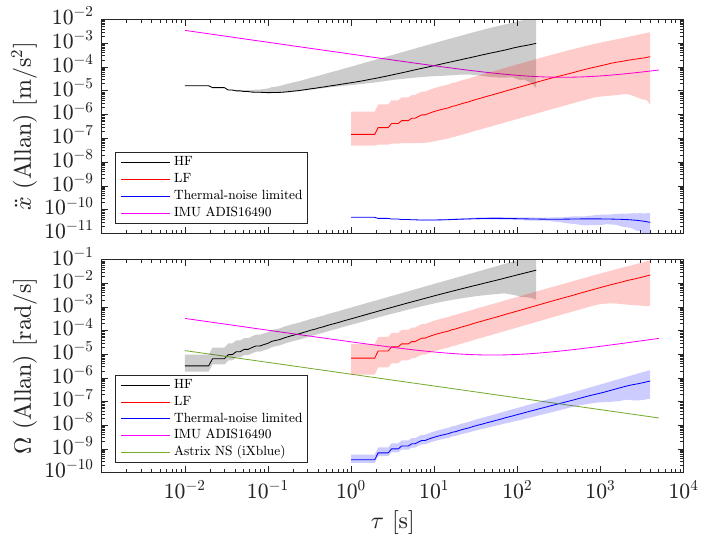
Figure 11. Allan deviation for linear acceleration ( top ) and angular velocity ( bottom ). HF and LF GF-INSs performance are shown in black and red, respectively. A tactical-grade MEMS-based inertial sensor (ADIS16490 from Analog Devices) and an optical gyroscope (Astrix NS from iXblue) are shown for comparison. Blue traces show the performance of an LF GF-INSs limited by the fundamental thermal noise limit of an optomechanical